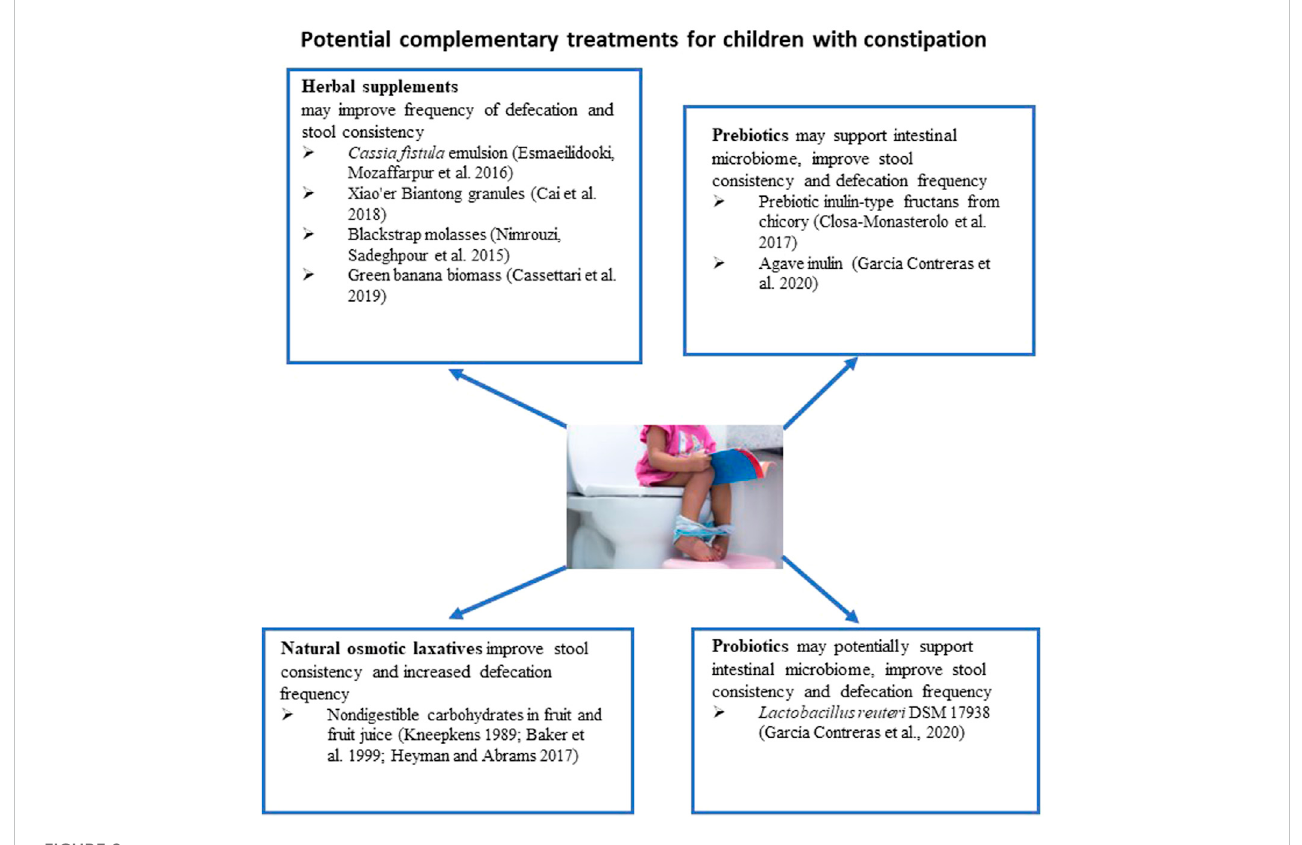
FIGURE 2 Potential Complementary Treatments for children with